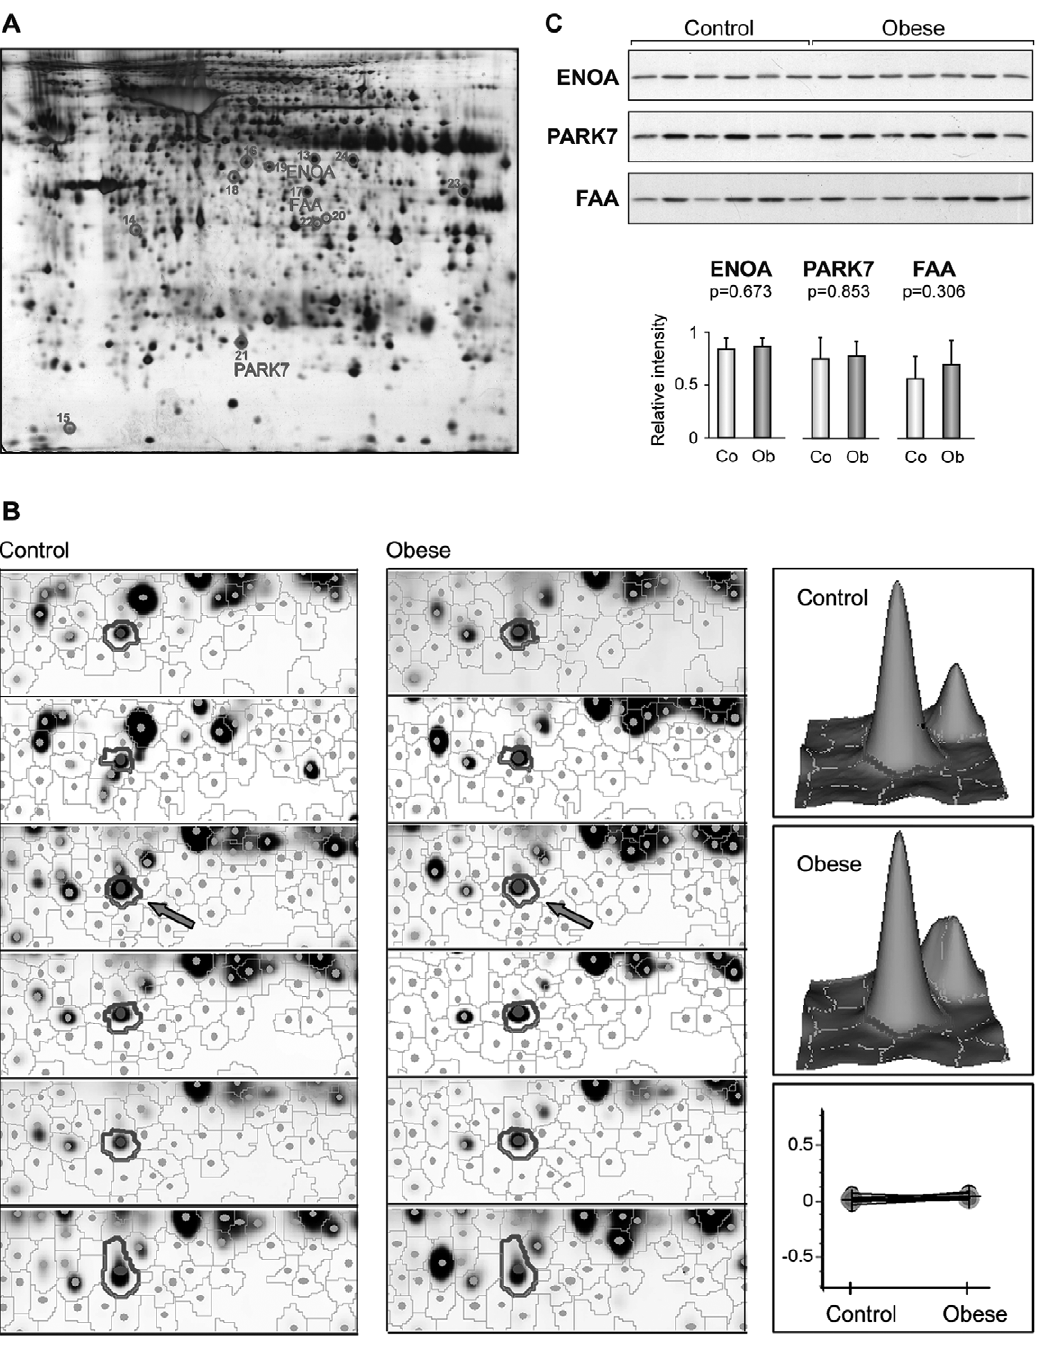
Figure 4. Proteins identified by 2D-DIGE and MS showing sustained expression levels in omental adipose tissue from non-obese and obese subjects. Protein extracts from omental fat of obese and non-obese subjects were analyzed by 2D-DIGE as described [19]. A selected silver-stained gel is shown with spots numbered as indicated in Table 1 (A). Sustained expression of PARK7 in obese and non-obese (control) subjects by DeCyder analysis. Zoomed images of 2D-DIGE gels around PARK7 spot (circled), 3D-view of selected spots (arrow) and graphical representation of the Standardized Abundance (Log) of PARK7 spot is shown (B). Representative Western Blot analysis of ENOA, PARK7 and FAA expression in omental fat samples from non-obese and obese subjects. Relative intensity values from band densitometry are expressed as mean 6 SD